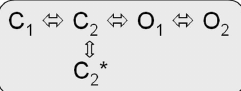
FIGURE 2 | Characteristics of Kv7.1/KCNE-mediated currents. (A) Representative current traces of Kv7.1 homomers and Kv7.1/KCNE1 heteromers. Channels were expressed in Xenopus oocytes, and currents were elicited with 7s pulses to potentials of − 100 to + 60mV, applied in 20mV increments from a holding potential of − 80mV.Tail currents were recorded at − 120mV. (B) Current-voltage relationships. At voltages between − 60 and − 40mV KCNE1 suppresses currents, whereas it stimulates them at voltages above 0mV. (C) Voltage dependence of channel activation determined by tail current analysis. Activation curves